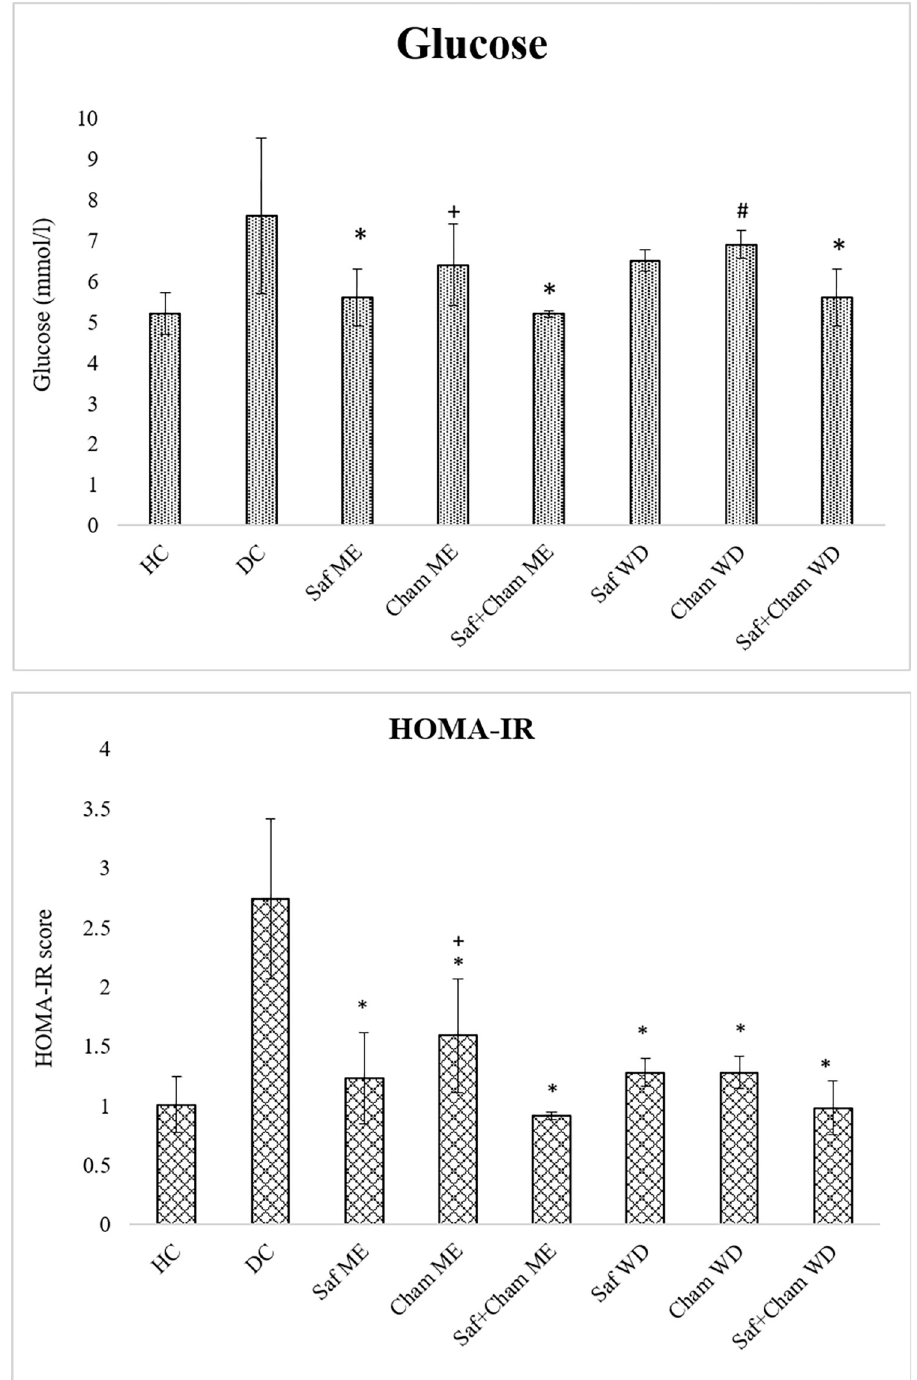
Fig 5. a: Effects of saffron, chamomile and their co-administration in ME and WD on fasting plasma glucose level in streptozotocin-induced diabetic rats, values are presented as means ± SD (n = 10). Tukey’s test shows significant values: � p < 0.05 from control DC, + p < 0.05 from Saf+Cham ME group, # p < 0.05 from Saf+Cham WD. b: Effects of saffron, chamomile and their co-administration in ME and WD on HOMA-IR in streptozotocin-induced diabetic rats. Values are presented as means ± SD (n = 10). Tukey’s test significant values: � p < 0.05 from control DC, + p < 0.05 from Saf+Cham ME group.